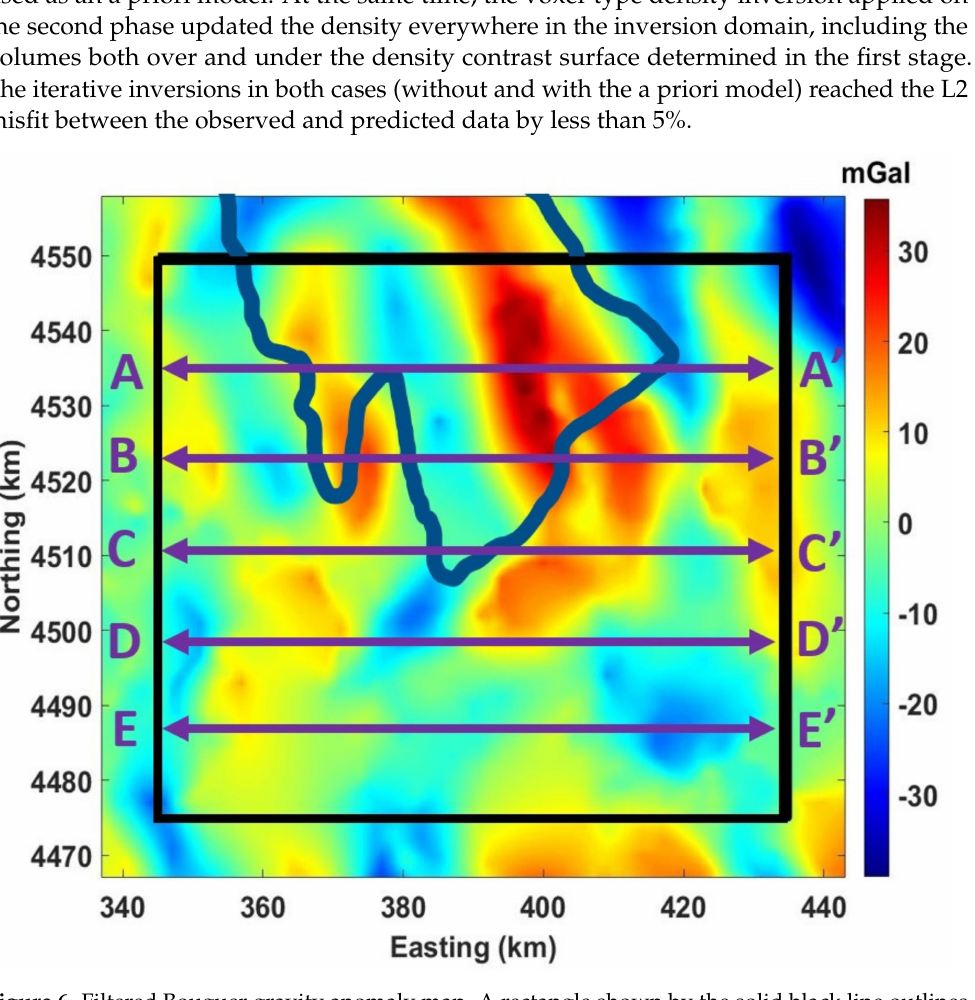
Figure 6. Filtered Bouguer gravity anomaly map. A rectangle shown by the solid black line outlines the AOI. The horizontal arrows are the profiles used in constructing the vertical sections of the density model produced by inversion. The dark blue line shows the contour of Great Salt